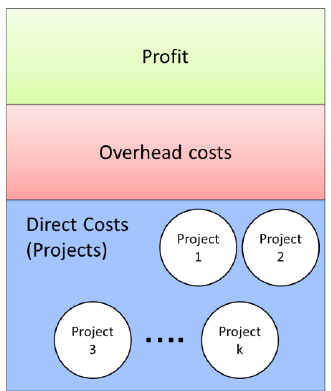
Fig. 1. Price breakdown structure of a project-based